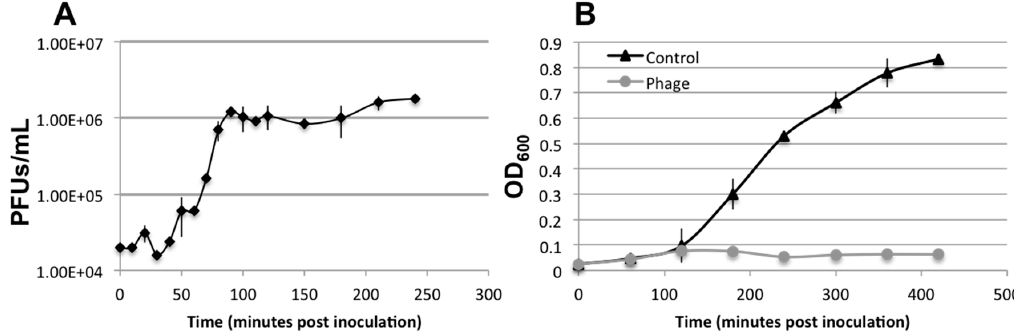
Figure 4. One ‐ step growth curve of lytic phage SFCi1 with its host, S. fidelis 3313, as determined by plaque forming units (PFUs) and bacterial turbidity measurements (OD 600 ).